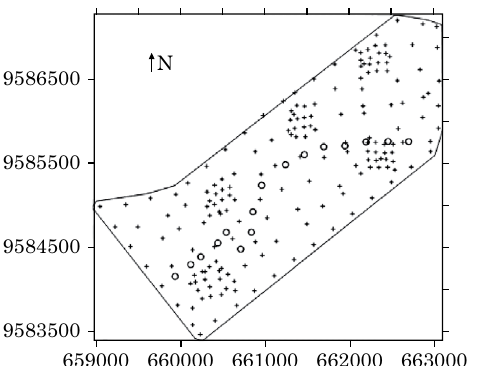
settlement.figure 1. elevation map with vectors of the different contour lines in the agrarian reform